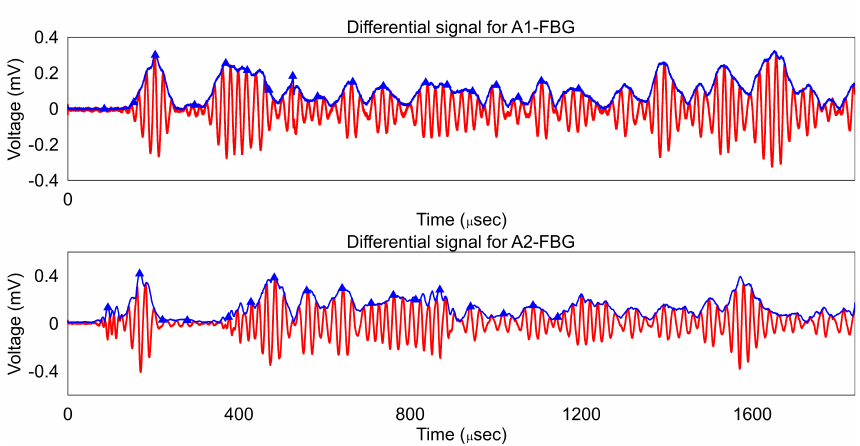
Figure 9. Differential signal with Hilbert envelope and identified peaks for scenario